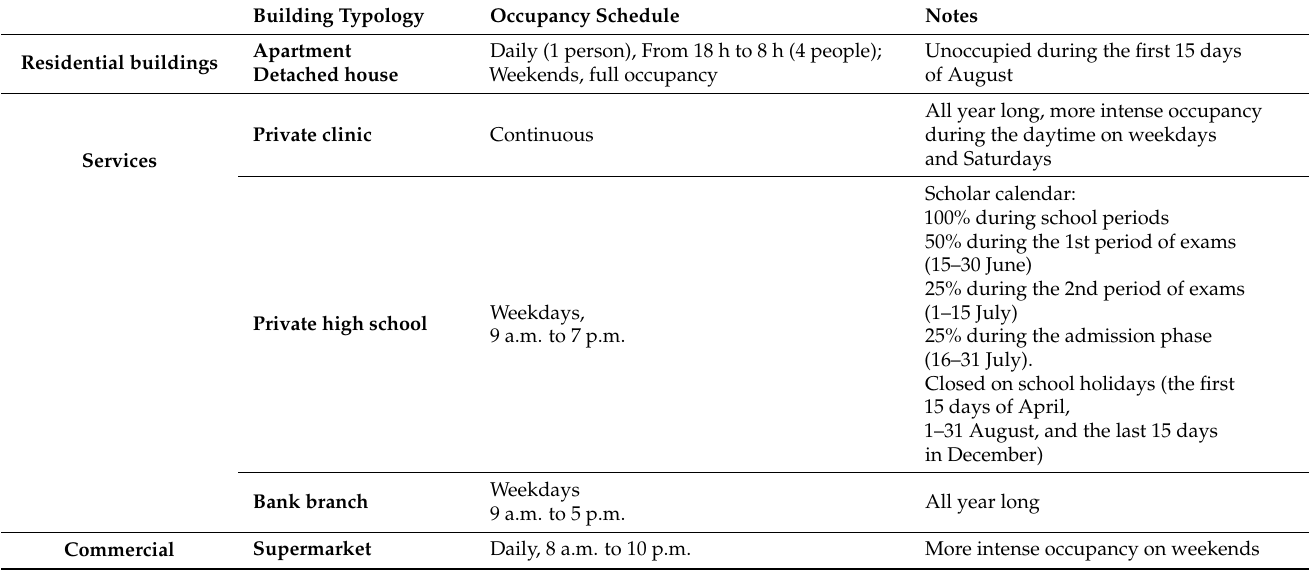
Table 6. Synthesis of operation and occupancy schedule for each